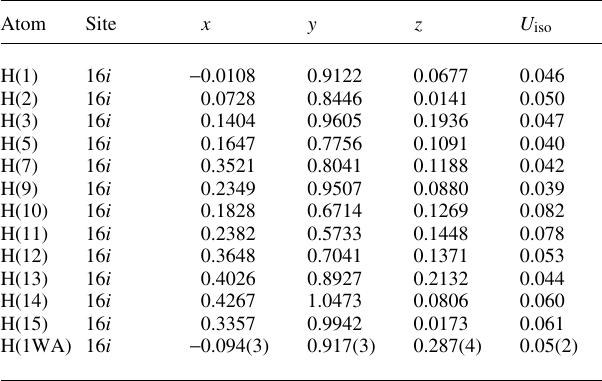
Table 2. Atomic coordinates and displacement parameters (in Å 2 )